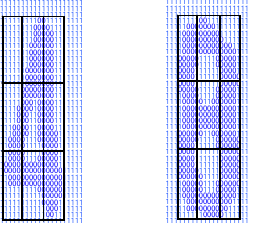
Fig. 2. Normalized images divided into 3  3 grids to calculate